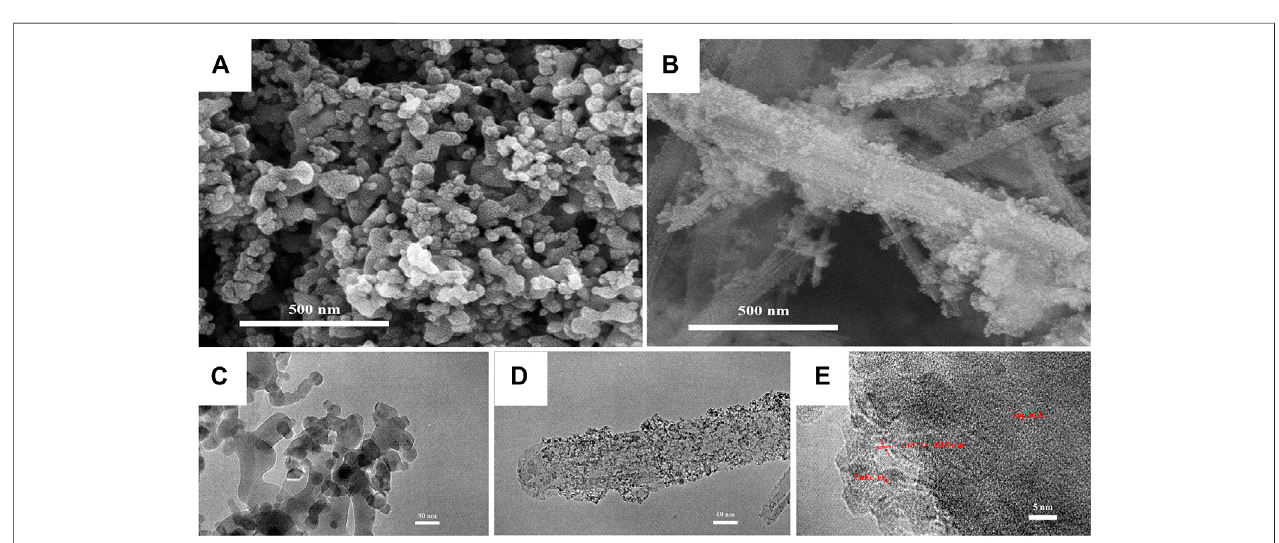
FIGURE 3 | SEM images of (A) ZnFe 2 O 4 (B) ZF-Sep-11; TEM images of (C) ZnFe 2 O 4 (D) ZF-Sep-11; HRTEM images of (E) ZF-Sep-11.